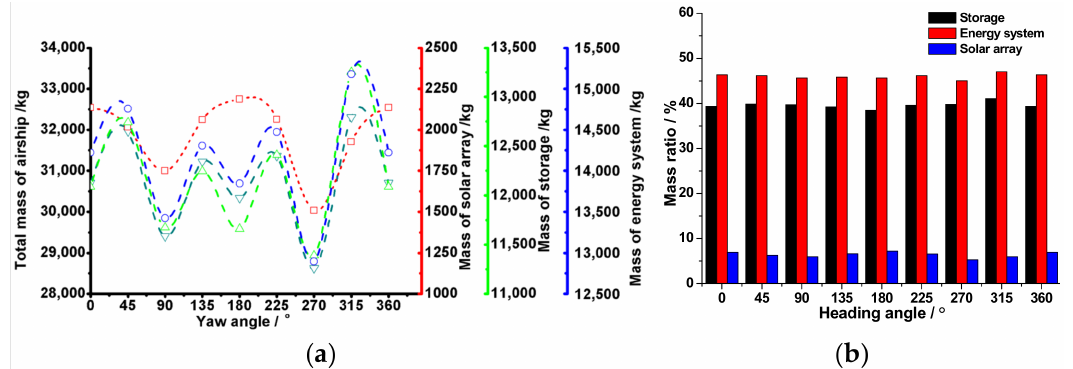
Figure 19. ( a ) The optimized total mass of airship, mass of solar array, mass of storage and mass of energy system for different heading angles. ( b ) The optimized mass ratios of solar array, storage battery and whole energy system for different heading